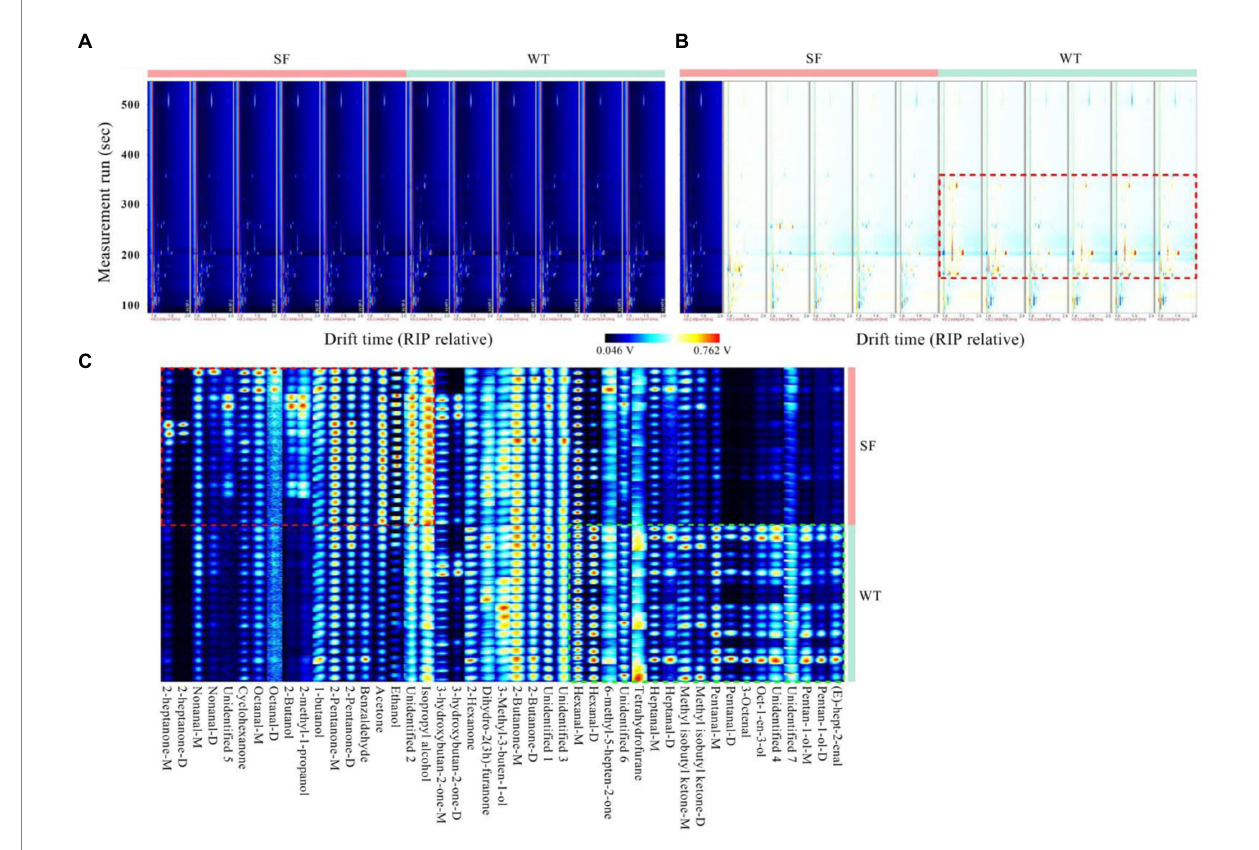
FIGURE 2 Comparison of the volatile components in donkey meats from two strains. Topographic representations of the spectra (A) , difference spectra (B) , and fingerprints of gallery plots (C) for volatile compounds. The brighter the color of the signal peak, the higher the concentration of the component. SF, Sanfen; WT, Wutou.